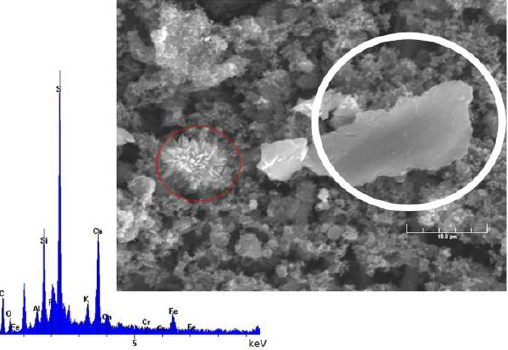
Figure 4. SEM micrograph of a dust sample from Hillingdon (collected on 02.08.2006) and EDX spectrum